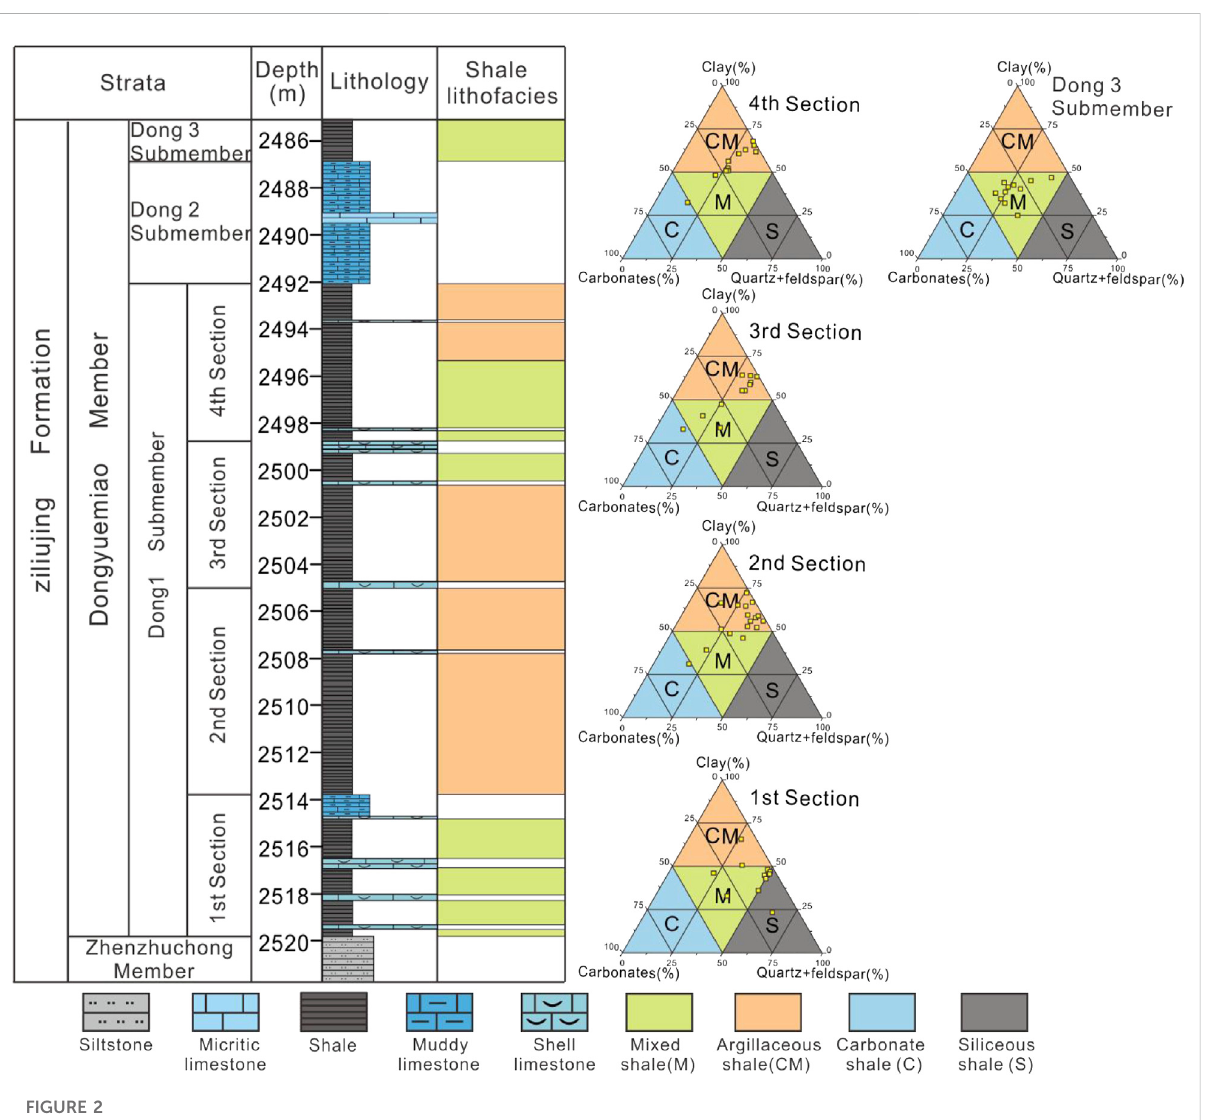
FIGURE 2 Shale lithofacies classi fi cation and vertical distribution of the Jurassic Dongyuemiao lacustrine shale in Eastern Sichuan Basin (based on Well XY4).